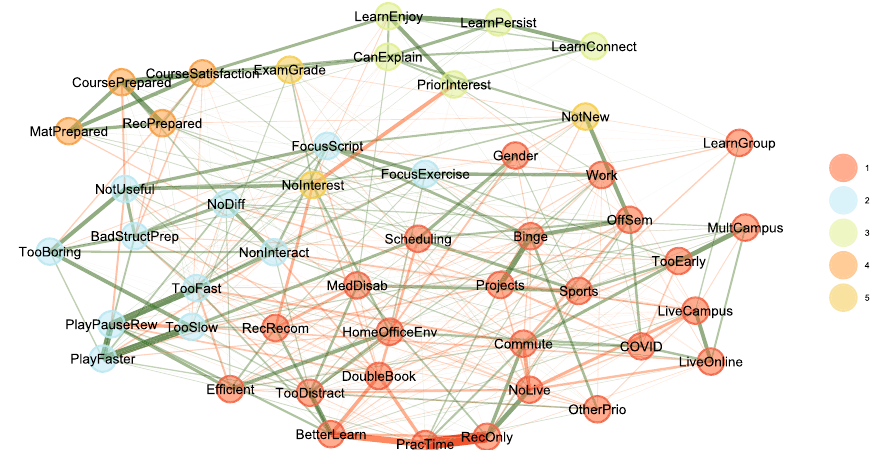
50% or LiveCampus < 50% (see ≥